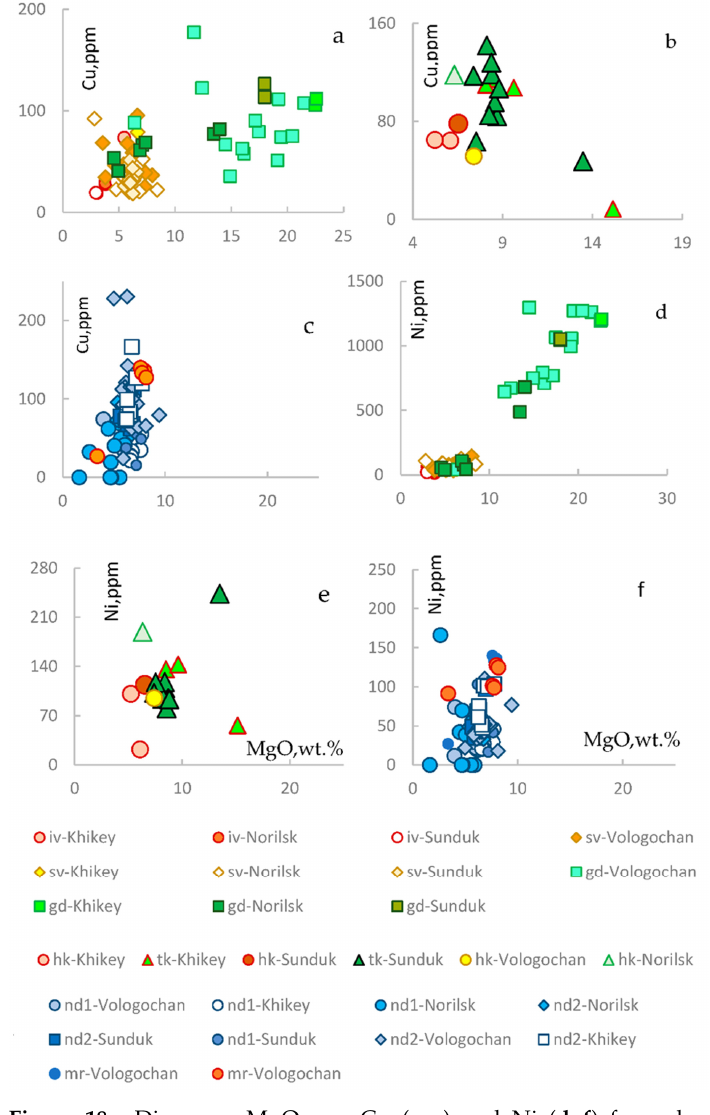
Figure 18. Diagrams MgO vs. Cu ( a – c ) and Ni ( d – f ) for volcanic rocks (( a , c )—Ivakinsky, Syverminsky, Gudchikhinsky Formations; ( b , e )—Tuklonsky Formation; ( c , d )—Nadezhdinsky, Morongovsky Formations).